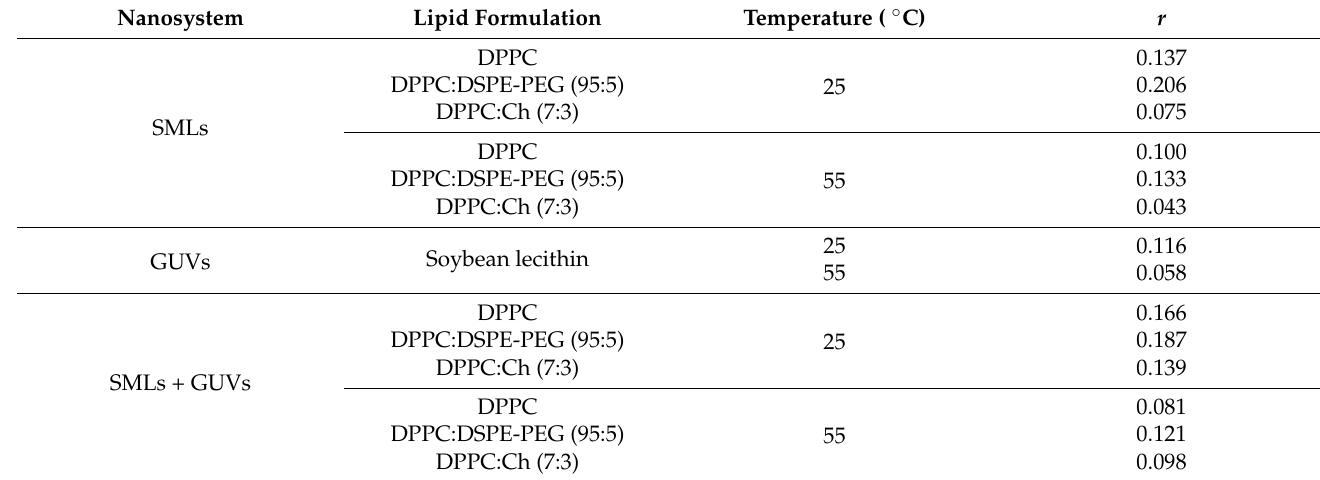
Table 4. Steady-state fluorescence anisotropy ( r ) values for doxorubicin in SMLs with different lipid formulations, in SMLs upon interaction with GUVs and in GUVs (for comparison). Total lipid con- centration: 1 × 10 − 3 M; DOX: 2 × 10 − 6 M.